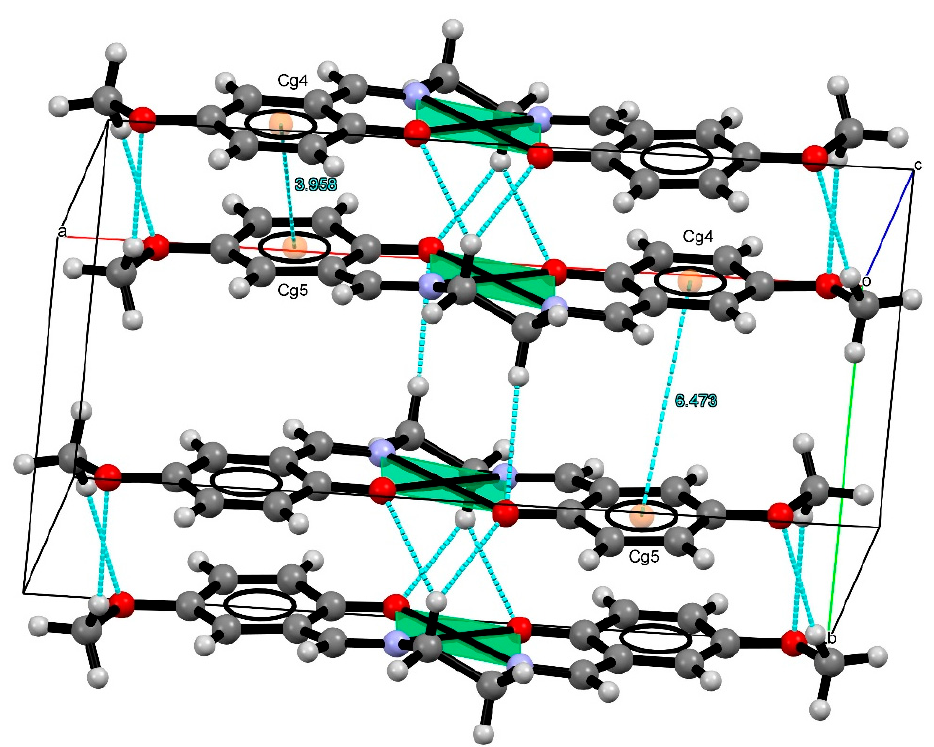
Figure 4. Crystal array of compound NiMeO salen . View along the c axes and with a perspective of a plane formed by the a-b axes, which emphasizes the R 12 (4) and R 22 (6) motifs , as well as π -stacking. The compound NiMeO salphen crystallized in a monoclinic crystal system with the space group P2 1 /